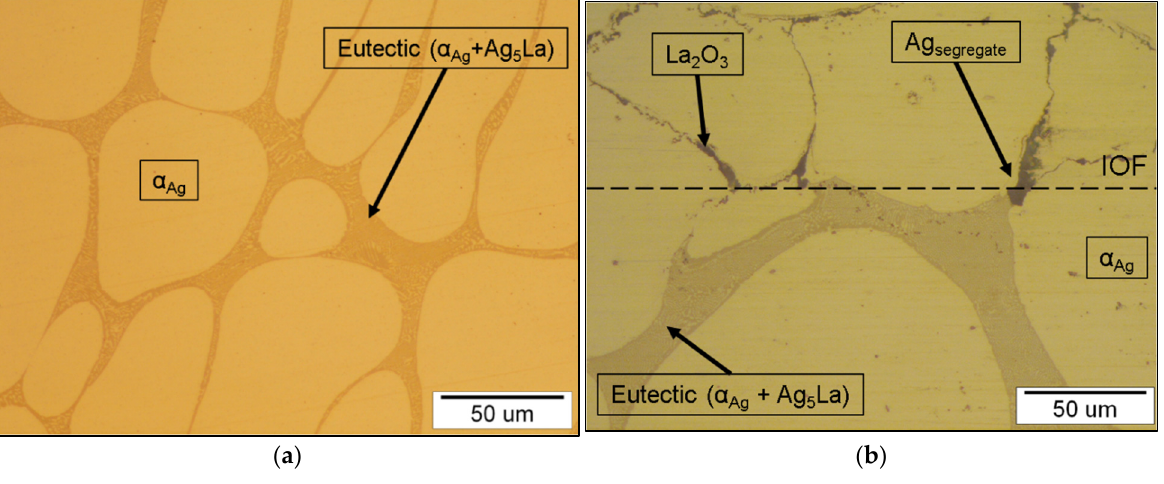
Figure 12. Microstructure of the Ag–2 wt.% La alloy: ( a ) as-cast and ( b ) transition between the non-oxidised (lower side) and internally oxidised (upper side) cast microstructure.